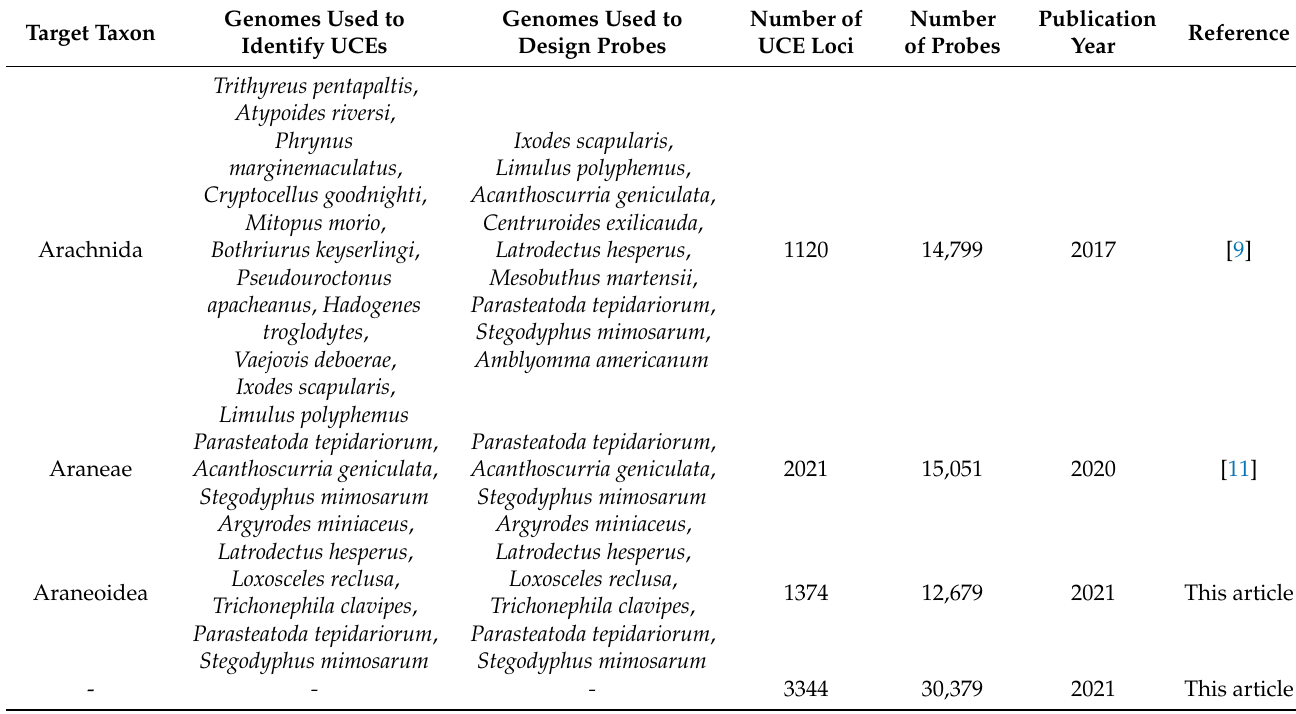
Table 2. List of the genomes for probe-set design and the numbers of captured loci. All probe sets used in this research are listed below, ordered by published year. This table displays the targeted taxa of probe-set design, species names of the genomes used to identify UCE loci, species names of the genomes used to design probes, number of UCE loci, number of probes, and the published year of the probe